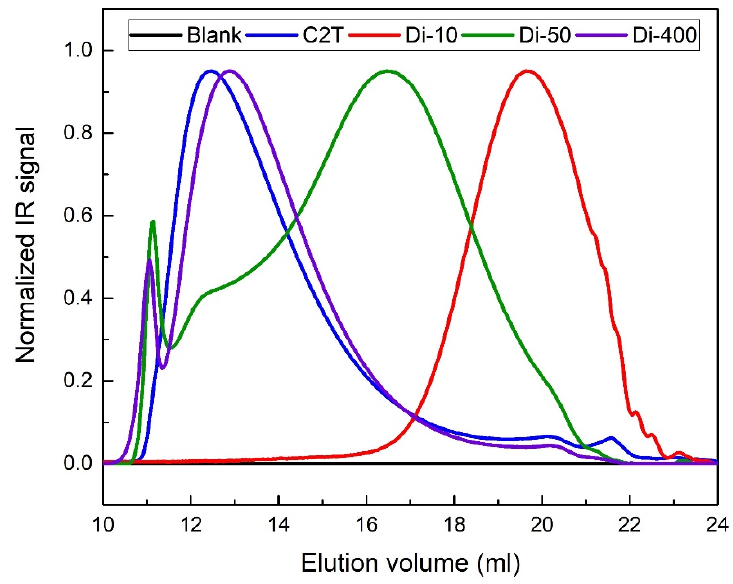
Figure A1. SEC eluograms of HO-PDMS-OH (C2T) and (MeO) 3 Si-PDMS-Si(OMe) 3 cross-linkers (Di-10, Di-50, and Di-400). Table A2. Compositions of silicone elastomers for long-term stability